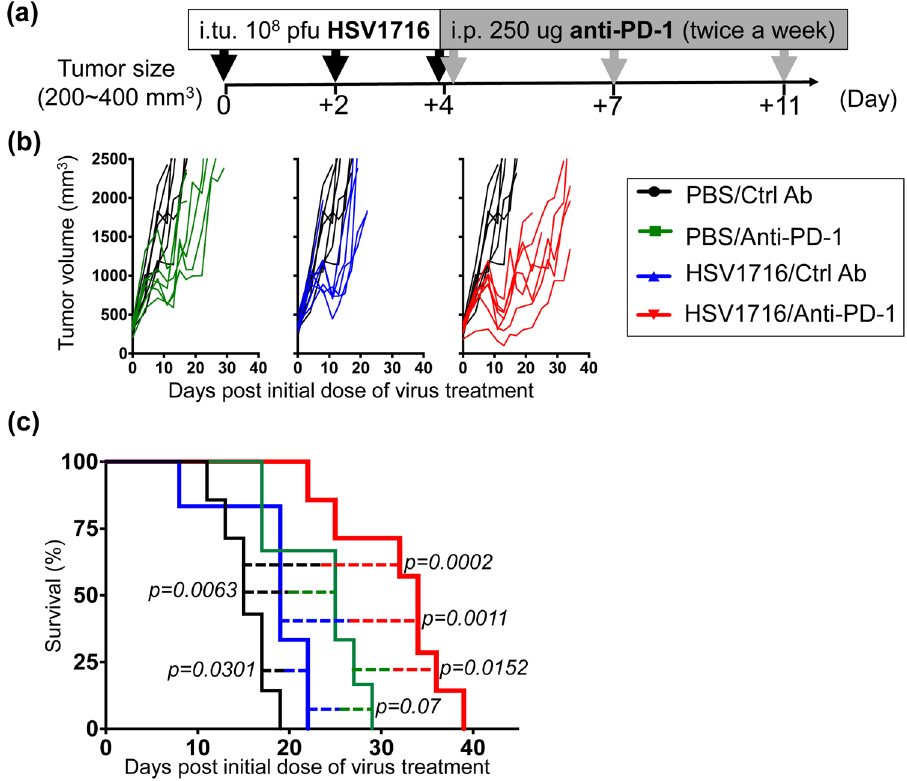
Figure 1. Combination of HSV1716 with anti-PD-1 antibody significantly prolongs survival in the male M3-9-M tumor model. ( a ) Schematic illustrates the dosing regimens for mice bearing subcutaneous M3-9-M tumors. Male C57BL/6 mice were implanted with 5 × 10 6 M3-9-M cells subcutaneously and treated with three intratumoral (i.tu.) injections of 10 8 pfu HSV1716 followed by intraperitoneal (i.p.) injections of anti-PD-1 antibody. ( b ) Tumor volumes of mice treated with anti-PD-1 (green lines; n = 6), HSV1716 (blue lines; n = 6) and combined therapy (red lines; n = 7) were measured twice a week and plotted individually against tumor volumes recorded for control mice (black lines; n = 7). ( c ) Kaplan-Meier survival curves for each treatment group demonstrate the improved efficacy of combining PD-1 blockade with HSV1716 virotherapy. Survival data were evaluated for statistical significance with Log-rank Mantel-Cox